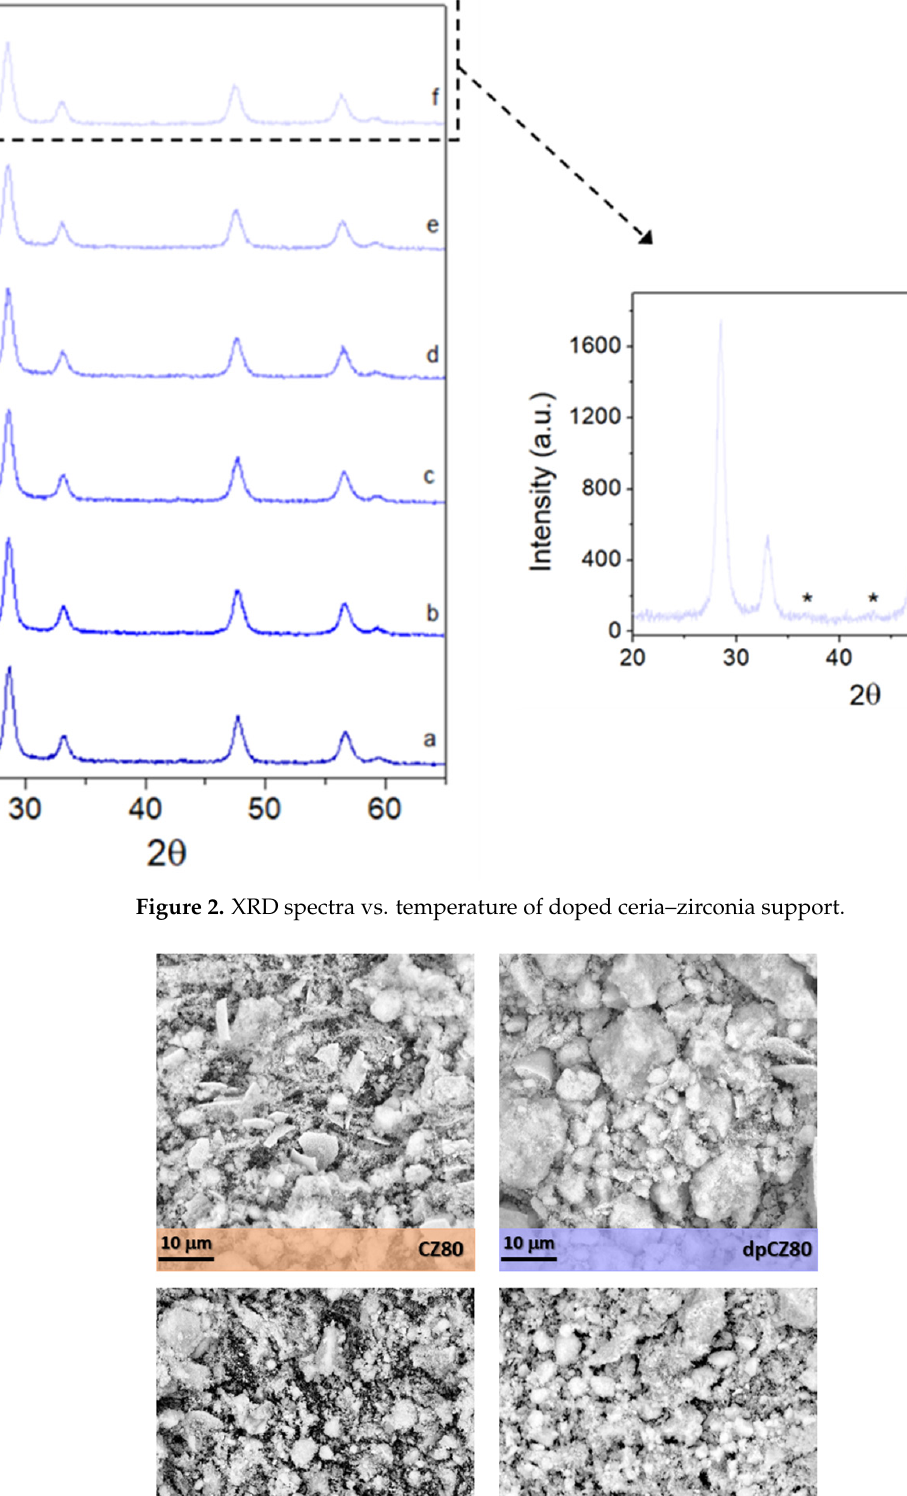
Catalysts 2023 , 13 , 165 4 of 17